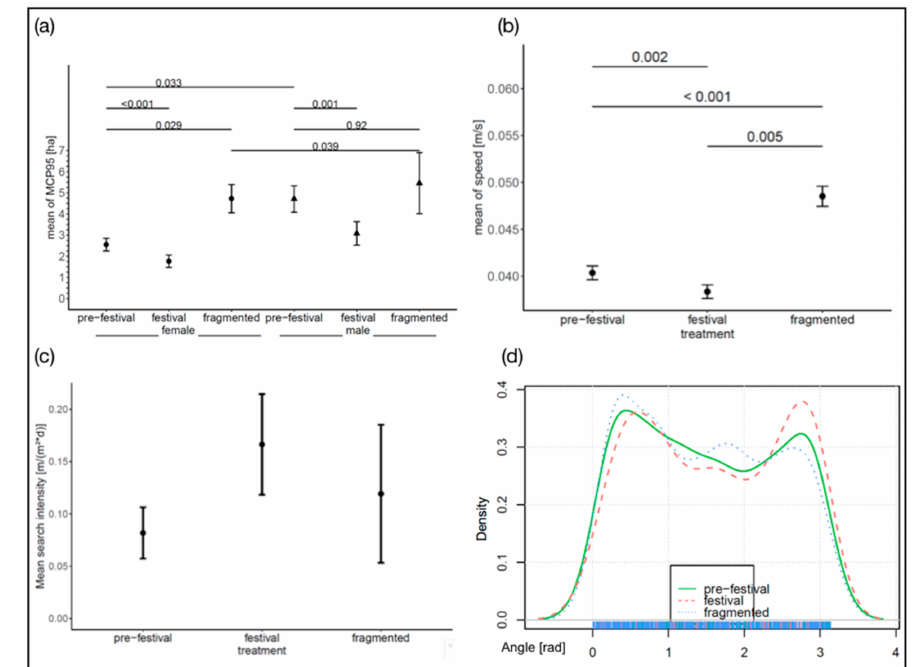
Figure 1. Results from the GPS data analyses. ( a ) MCP 95 measured per treatment and sex per day (dots / triangles indicate mean values, whiskers are confidence interval); ( b ) mean speed (m / s) for each treatment over both sexes (dots indicate mean values, whiskers are confidence interval); ( c ) mean search intensity (m / (m 2 × d)) for each treatment over both sexes (dots indicate mean values, whiskers are confidence interval); ( d ) Distribution of absolute turning angles of one subsample that were